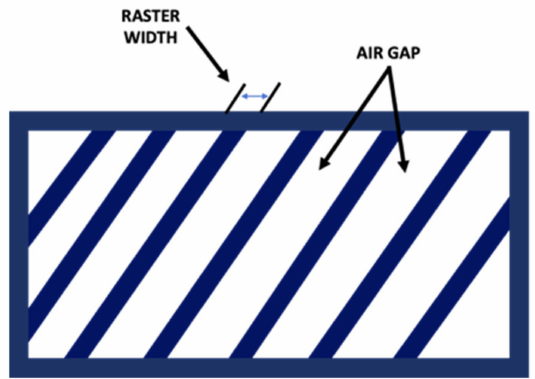
Figure 5. Raster width and air gap.